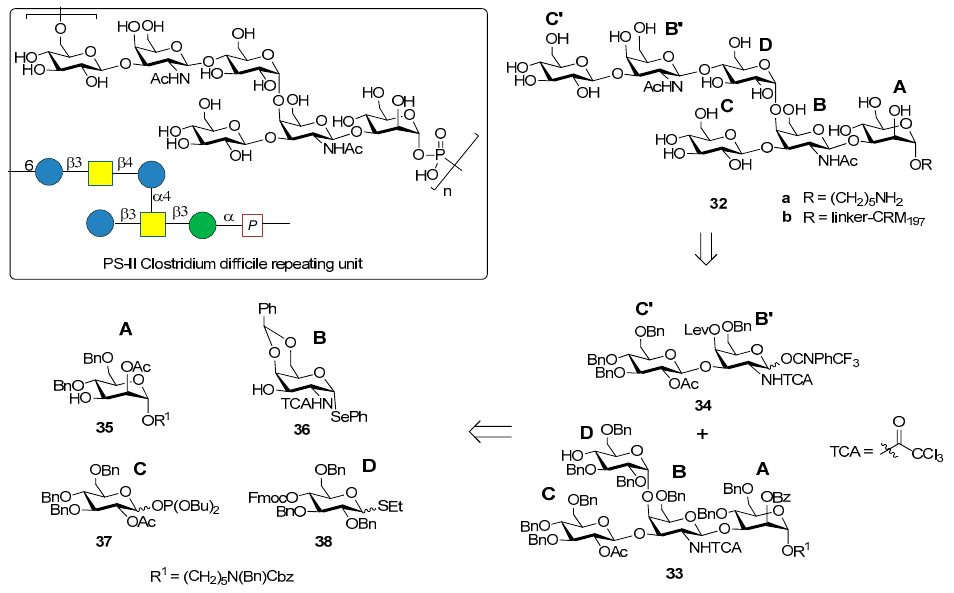
Figure 4. C. difficile PS-II repeating unit and retrosynthetic analysis of fragment 32 reported in [32].